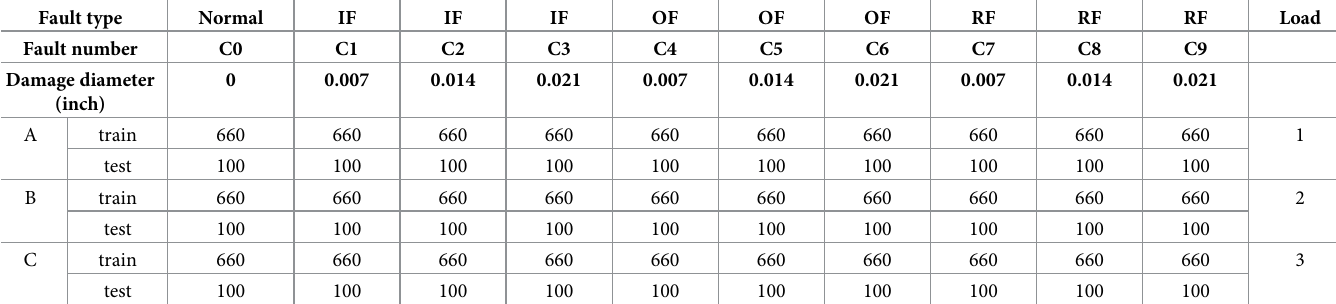
Table 1. Description of experimental